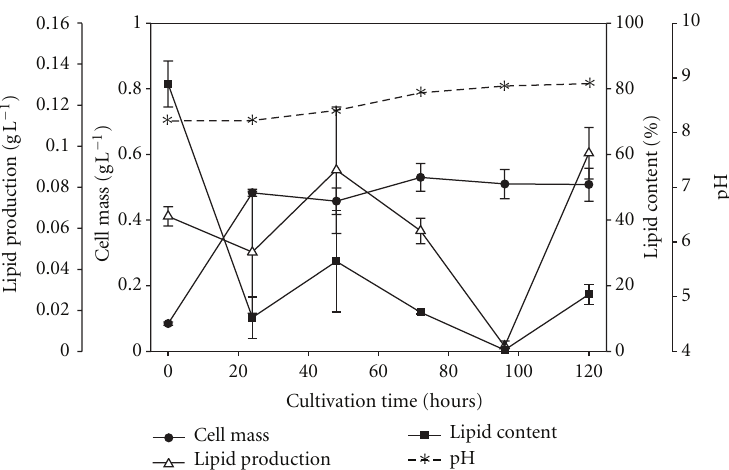
Figure 1: Cell mass production, lipid production, and lipid content of R. glutinis during cultivation on wastewaters from fruit juice processing.